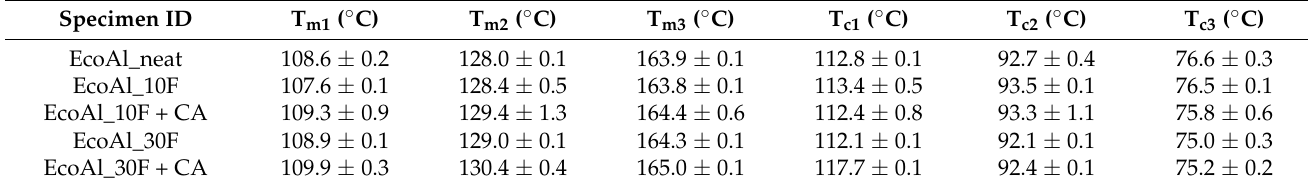
Figure 2. DSC second heating scan ( a ) and cooling scan ( b ) for EcoAllene-based composites. Table 3. Thermal properties of composites obtained from differential scanning calorimetry (DSC) analysis (T m = melting temperature; T c = crystallization temperature. Numbers 1 to 3 refer to the temperatures labeled in Figure 2).